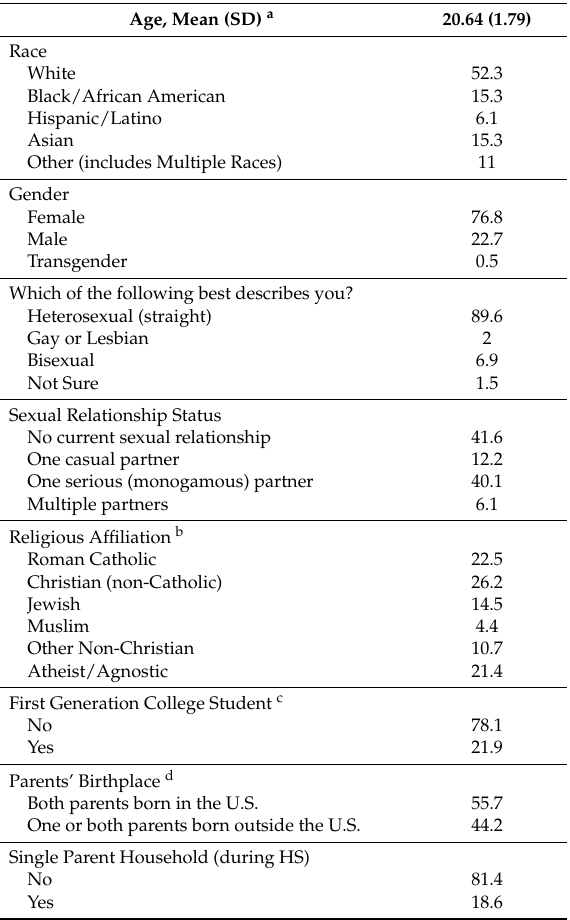
Figure 1. Students ’ Sexual Activity: Ever Unprotected vs. Always Protected ( n = 608).